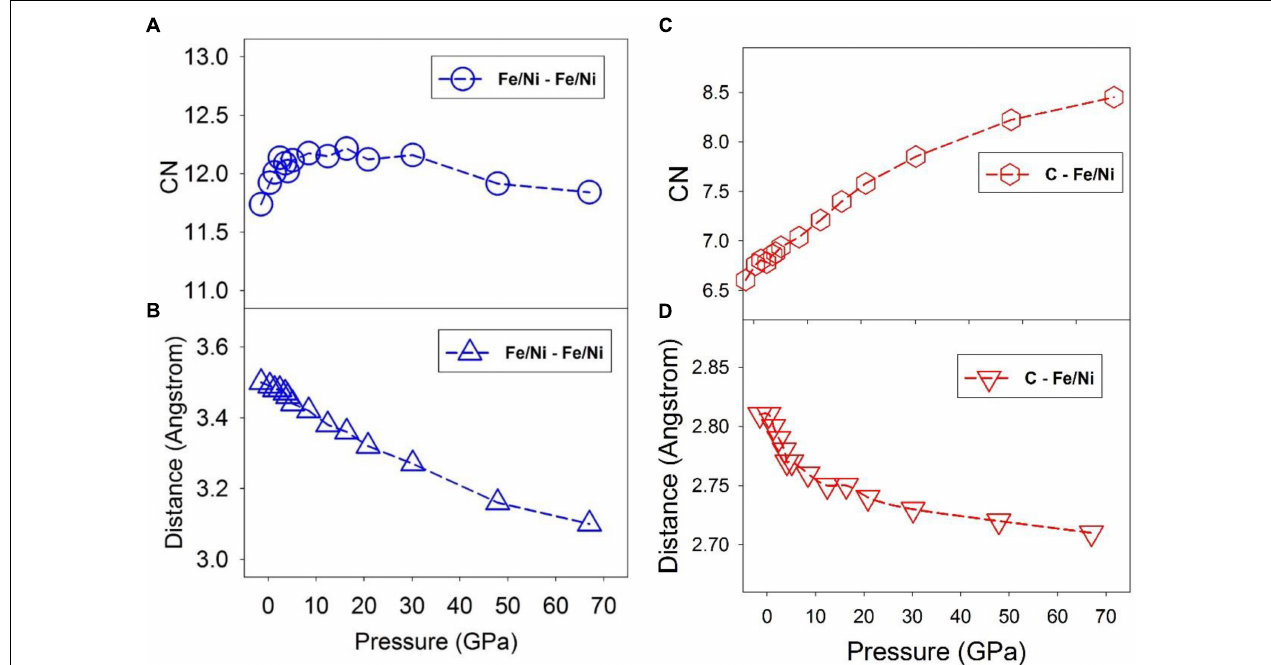
FIGURE 3 | Coordination number (CN) of nearest neighbor and first minimum distance of the PDF at 1673 K and different pressures. Dashed lines are intended to guide the eye. (A) Fe/Ni – Fe/Ni CN. (B) Fe/Ni – Fe/Ni distance of the first minimum of the PDF. (C) C – Fe/Ni CN. (D) C – Fe/Ni distance of the first minimum of the